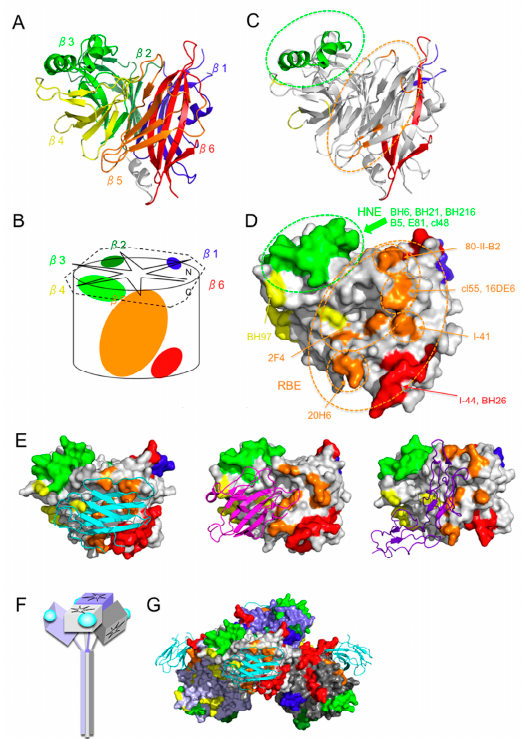
Figure 2. Side view showing RBE and HNE. ( A ) Ribbon diagram. The β -sheets 1, 2, 3, 4, 5, and 6 are shown in blue, red, orange, yellow, light green, and green, respectively; ( B ) Schematic diagram. Light green, blue, and green ovals indicate locations of HNE, NE, and LE, respectively. Orange and red ovals indicate the locations of RBE. Black solid and dashed lines indicate the overall structure of the H protein; ( C , D ) Locations of RBE and HNE. Amino acids demonstrated or suggested to constitute a portion of an epitope are shown in colors: residues on β -sheets 1, 2, 3, 4, 5, and 6 are shown in blue, red, orange, yellow, light green, and green, respectively. Orange and light green dashed-line circles indicate the locations of RBE and HNE, respectively. ( C ) Ribbon diagram. ( D ) Surface presentation and MAbs that recognize RBE and HNE; ( E ) Structures of MV-H complexed with SLAM (left), nectin-4 (middle), or CD46 (right). Surface presentation models show MV-H and cartoon models show SLAM (cyan) [18], nectin-4 (magenta) [19], and CD46 (purple) [20]; ( F , G ) MV-H tetramer complexed with SLAM (form I) [18]. Four H protein molecules are shown in gray, light gray, purple, and light purple. SLAM is shown in cyan. ( F ) Schematic diagram. ( G ) Surface presentation models represent MV-H and cartoon models represent SLAM [18].